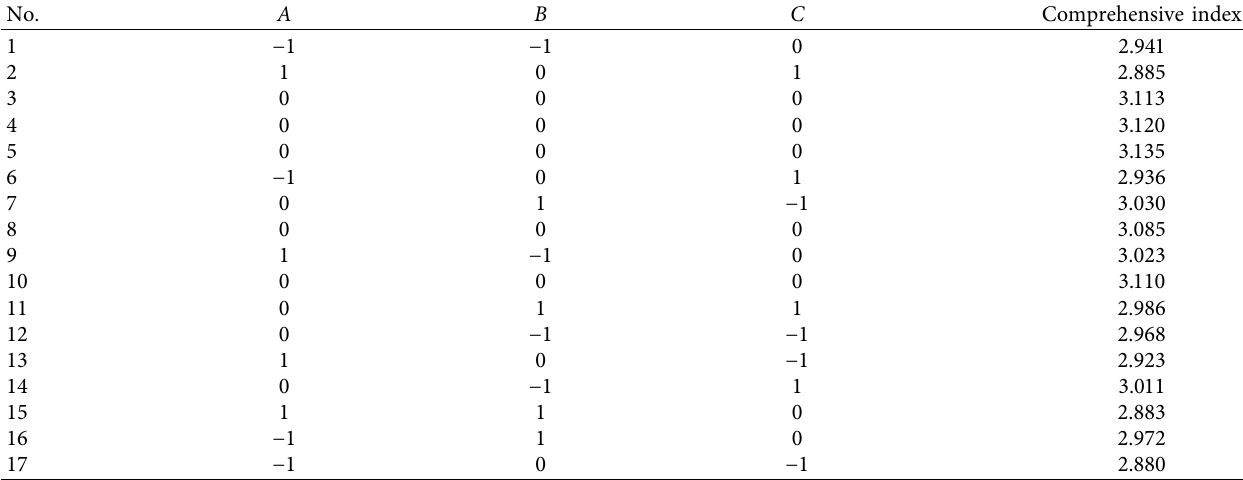
Table 6: Design plan results.